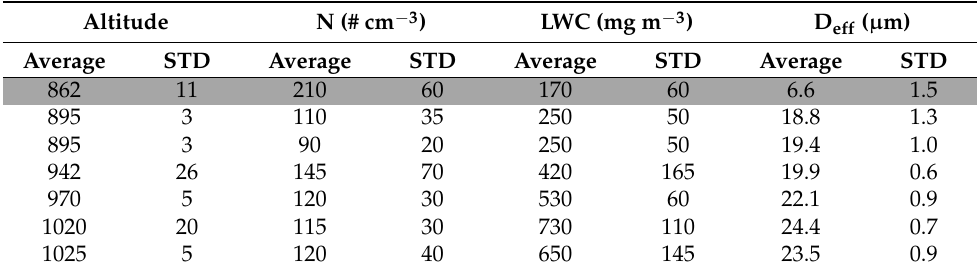
Table A1. Average and standard deviation (STD) of droplet number concentration (N), with LWC and effective diameter (D eff ) derived from the indicated horizontal tracks through a SC field in the vicinity of the CHIEF cloud chamber. Grey background is used for data measured at cloud base with higher variability in D eff